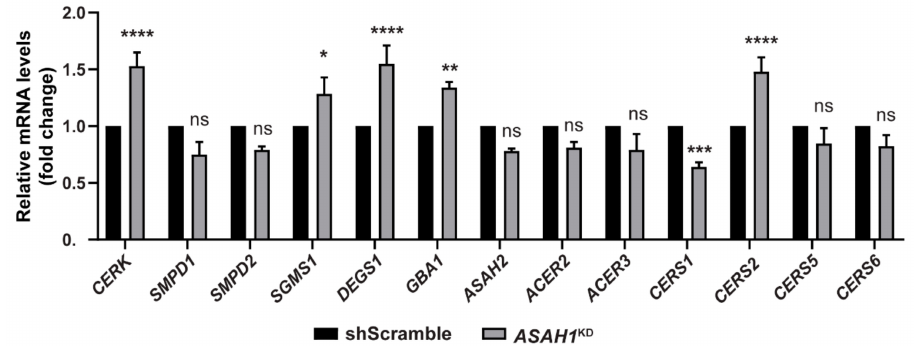
Figure 10. Altered mRNA levels of genes expressing enzymes of ceramide metabolism in ASAH1 KD cells. The graph represents the mRNA levels of CERK (Cer kinase), SMPD1 and SMPD2 (acid and neutral sphingomyelinase), SGMS1 (SM synthase 1), DEGS1 (delta 4-desaturase, sphingolipid 1), GBA (glucosylceramidase beta), ASAH2 (neutral ceramidase), ACER2 and ACER3 (alkaline ceramidases 2 and 3) and ceramide synthases ( CERS1 , CERS2 , CERS5 , and CERS6 ) sphingolipid genes in ASAH1 KD cells relative to shScramble cells after normalization with the endogenous GAPDH gene. Values represent the mean ± SEM of three independent triplicate experiments. Asterisks indicate statistically significant (* p < 0.05, ** p < 0.01, *** p < 0.001, and **** p < 0.0001 significant, two-way ANOVA analysis).